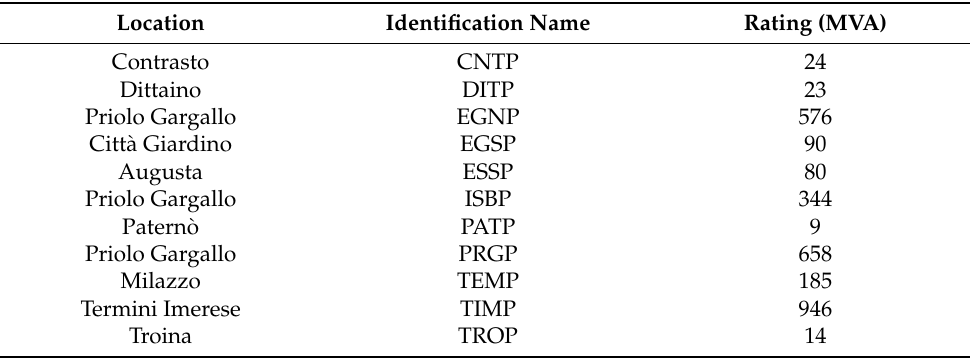
Table 5. Ratings and location of the synchronous power plants in 2050.